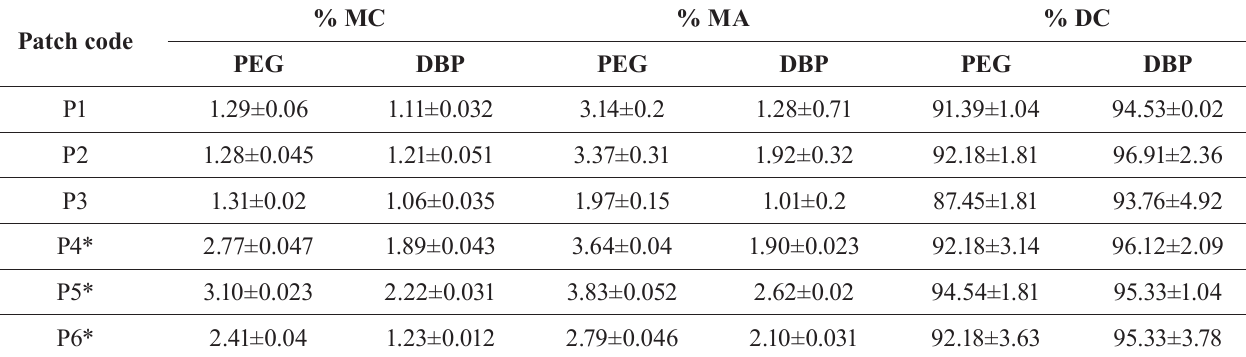
TABLE V - D ata of Percentage moisture content, percentage moisture absorption and percentage drug content. ( n=3 )